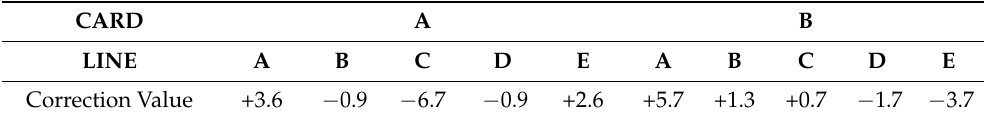
Table 8. Correction grid aimed to uniform the mean performance on the execution times for each line and